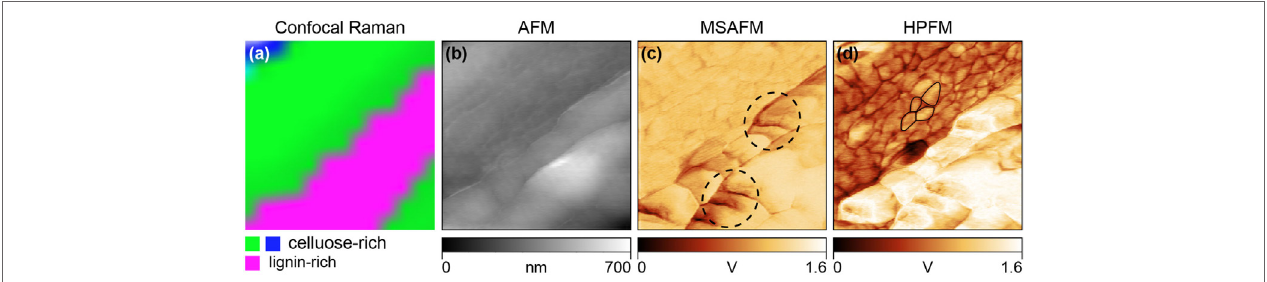
FiGURe 4 | Demonstration of HPFM compared to confocal Raman, AFM, and MSAFM on EF (extractive-free) poplar cell wall. (A) Confocal Raman image showing lignin-rich (pink) and cellulose-rich (blue, green) regions. (B) Simultaneous AFM image showing only topography. (C) MSAFM image at difference frequency, ω − = 26 kHz, brings additional clarity to the lignin structures indicated by the dashed circled regions. (D) HPFM image at photonic actuation, ω QCL → ω _ = 26 kHz, reveals additional detail of the near-surface cellulosic globules shown outlined. Adapted from Tetard et al.